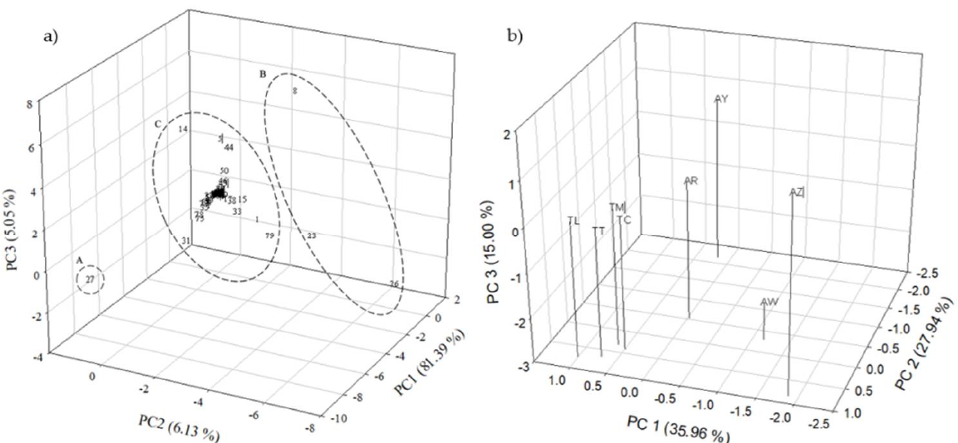
Figure 1. Principal component analysis (PCA). ( a ) PCA of the first three factor scores and factor loadings of volatile compounds of all samples of Tejuino fresh artisanal and commercial samples.